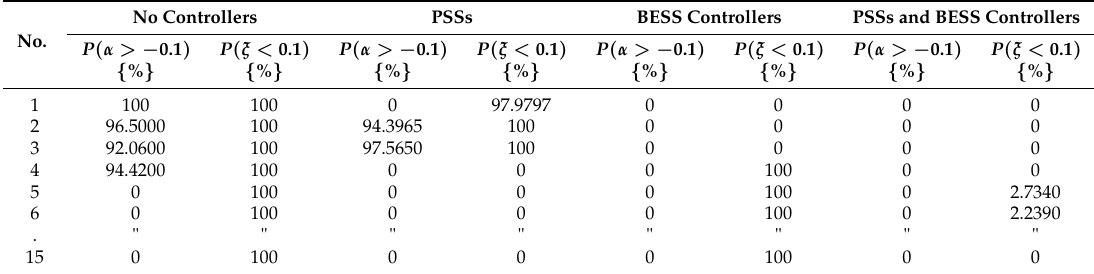
Comparison of stability indices under different controller conditions using the optimization-based tuning method